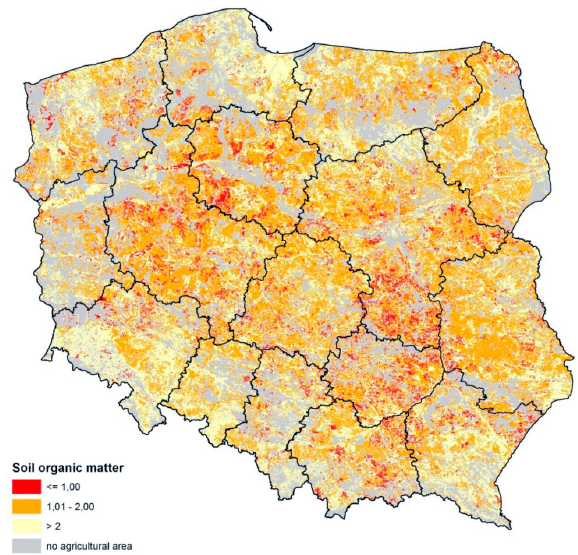
Fig. 1C. Soil organic matter in Poland ( Stuczyński, Jadczyszyn 2007; discussion in the Supplementary Material)